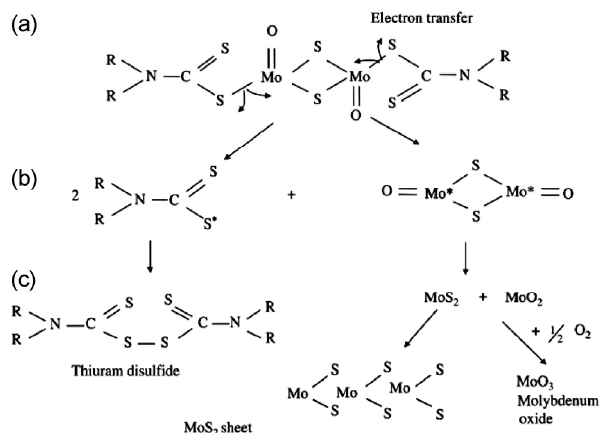
Fig. 14 Molybdenum dialkyl dithiocarbamate (MoDTC) decom- position chemical model [55, 56]. Reproduced with permission from Ref. [56]. Copyright Elsevier,